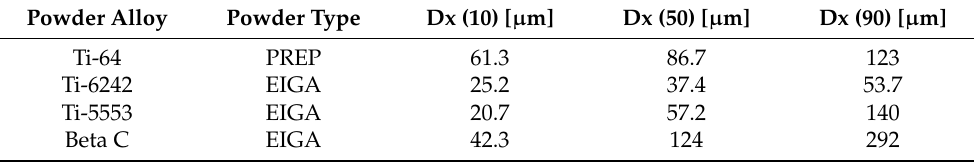
Table 1. Type and average statistical powder size distribution of the materials used in this study.